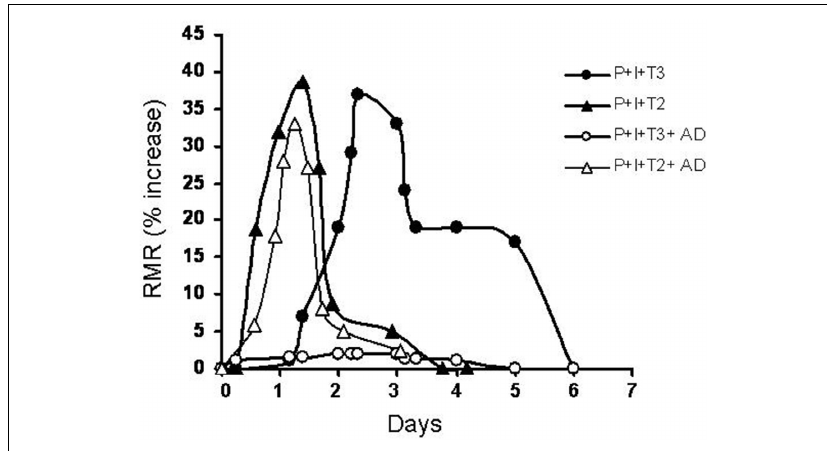
FIGURE 1 | Time course of variation in the resting metabolic rate of hypothyroid rats following administration of a single dose of iodothyronines (25 μ g/100g BW for both T 2 and T 3 ) with or without a concomitant administration of actinomycin D (8 μ g/100g BW) (AD). Hypothyroidism was induced by combined treatment with PTU and IOP (P + I). Resting metabolic rate (RMR) is reported as % increase [vs. time 0 (immediately before the